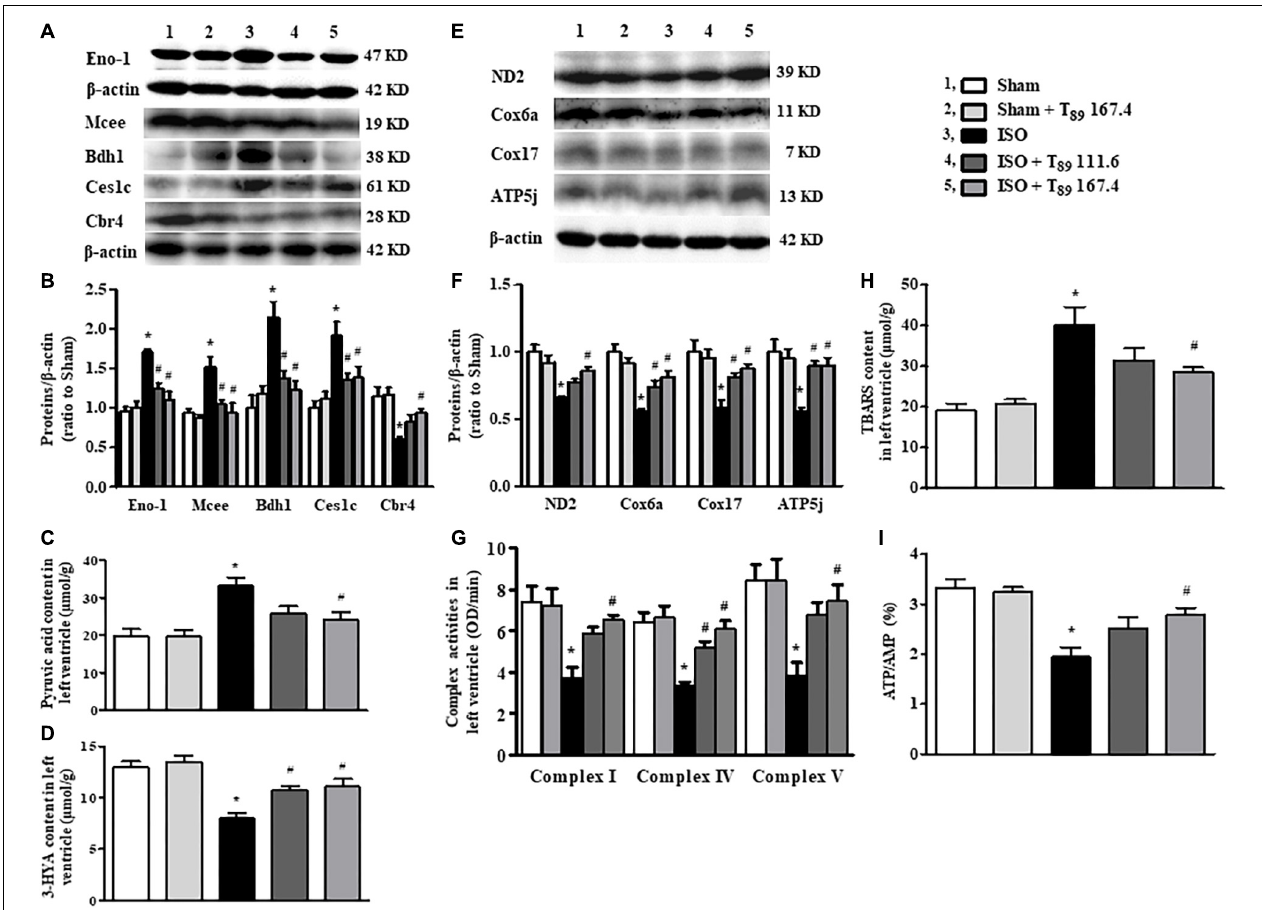
FIGURE 5 | Effect of T 89 on ISO-induced alteration in metabolism and mitochondrial function. (A , B) Representative Western blotting bands and quantitative analysis of Eno1, Mcee, Bdh1, Ces1c, and Cbr4 in various groups. n = 4. (C , D) The content of pyruvic acid (C) and 3-HYA (D) in left ventricles in different groups. n = 6. (E , F) Representative Western blotting bands and quantitative analysis of ND2, Cox6a, Cox17, and ATP5j in various groups. n = 4. (G) The activity of complex I, IV, and V in left ventricles. n = 6. (H , I) The level of TBARS (H) , and the ratio of ATP/AMP (I) in left ventricles. n = 6. * P < 0.05 vs. Sham group, # P < 0.05 vs. ISO group.